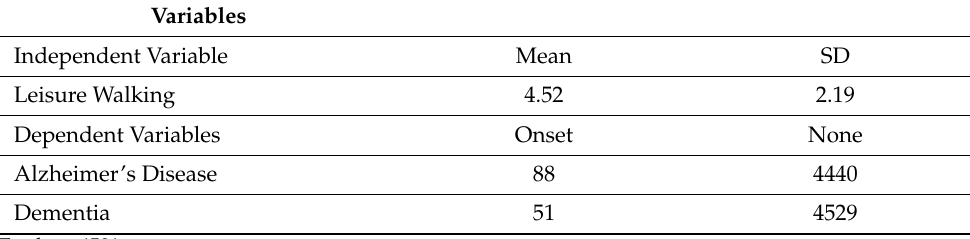
Table 2. Descriptive statistics of leisure walking, Alzheimer’s disease, and dementia. Variables Independent Variable Mean SD Leisure Walking 4.52 2.19 Dependent Variables Onset None Alzheimer’s Disease 88 4440 Dementia 51 4529 Total n =